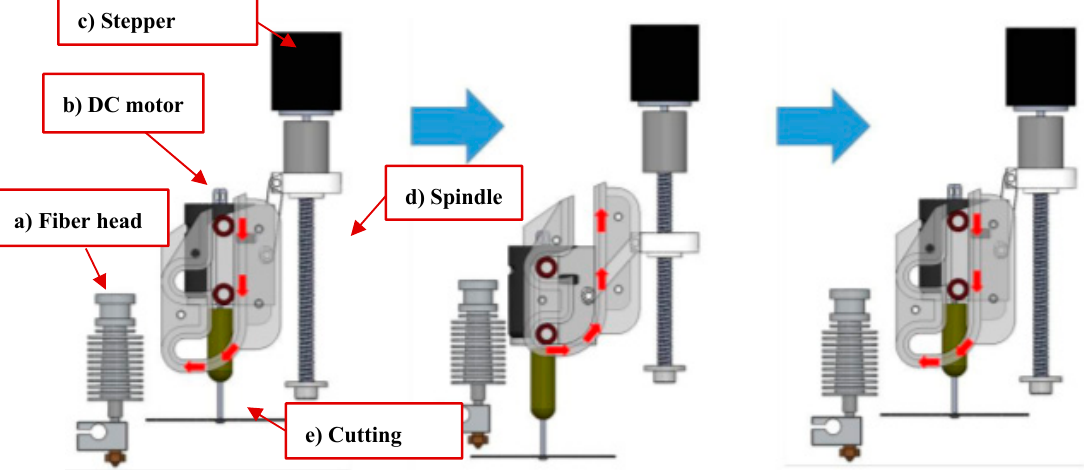
Figure 6. Operating scheme of fiber cutting system; ( a ) fiber deposition head; ( b ) direct current (DC) motor; ( c ) stepper motor; ( d ) spindle; ( e ) fiber cutting disc.